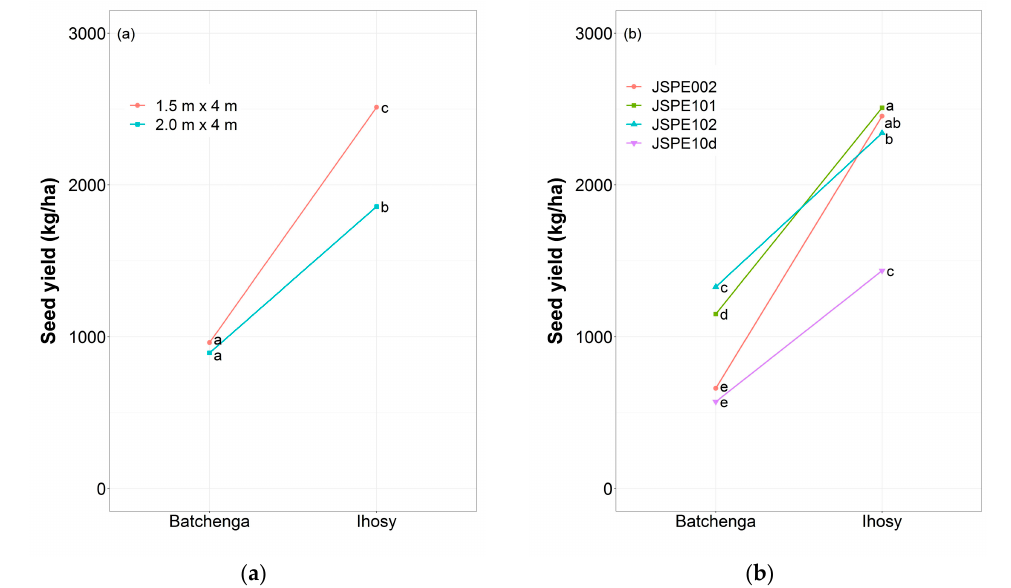
Figure 2. Mean seed yields (kg/ha, 3rd year) of spacings ( a ) and half sib families ( b ) at Batchenga and Ihosy displaying spacing-by-environment and genotype-by-environment interactions, respectively. Means followed by same letter are not significantly different at α = 5%.